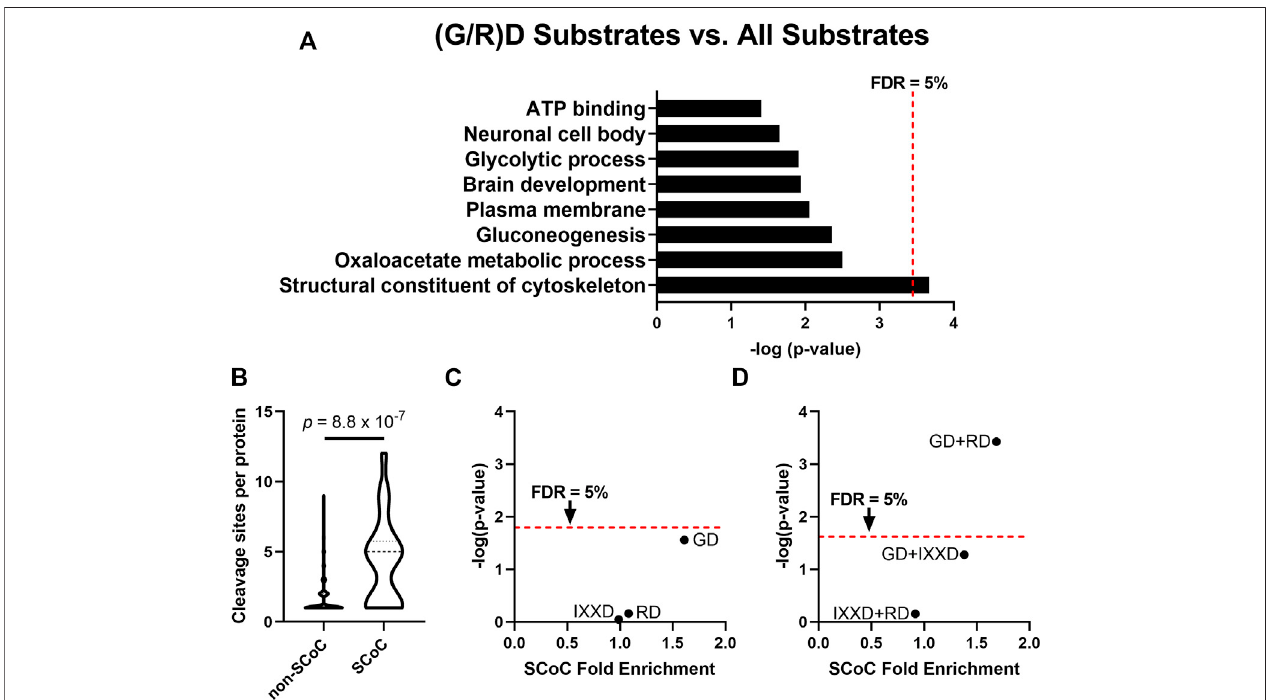
FIGURE 2 | The P2 position of the non-apoptotic auditory brainstem caspase consensus sequence is associated with substrates enriched for the GO term “ StructuralConstituent ofCytoskeleton ” (SCoC). (A) TheDAVIDBioinformatics Resource6.8 wasused toexamine GOterms ofnon-apoptoticchickauditory brainstem substrates with at least one GD or RD site. These substrates with consensus-like sites were signi fi cantly more likely to have the GO term “ Structural Constituent of Cytoskeleton ” (SCoC) than were auditory brainstem caspase substrates as a whole. (B) “ Structural Constituent ofCytoskeleton ” substrates had agreater number ofcaspasecleavage sites per protein per replicate thanothersubstrates(MannWhitney U-test). Thisresultsuggeststhatanalternativemethod isneeded toensure that theenrichmentofSCoCproteinsamongcaspasesubstrateswithconsensus-likesitesisnotduetoSCoCproteinshavingalargenumberofcleavagesites,anyofwhich could be consensus-like. (C) For each motif in the non-apoptotic auditory brainstem consensus sequence, Monte Carlo analysis was used to simulate the number of SCoC proteins expected to be cleaved at least once at that motif in each replicate (denoted a “ protein-cleavage ” ) based on each replicate ’ s overall frequency of each motif.Totalprotein-cleavagecountswereobtainedbysummingthecountsforeachreplicate.Thedistributionofexpectedprotein-cleavagetotalswascomparedtothat of observed protein-cleavage counts to obtain the SCoC Fold Enrichment and p -value. Only the GD motif was enriched among SCoC substrates ( q = 0.086), while RD and IXXD were cleaved at chance. (D) The three double-motif combinations of the non-apoptotic auditory brainstem consensus sequence were subjected to Monte Carloanalyses asin part C.The GD +RD motif combination wasenriched among SCoC substrates even more than either ofits constituentmotifs ( q =7.8 × 10 – 4 ).FDR: False Discovery Rate, derived by Benjamini, Krieger, and Yekutieli correction.